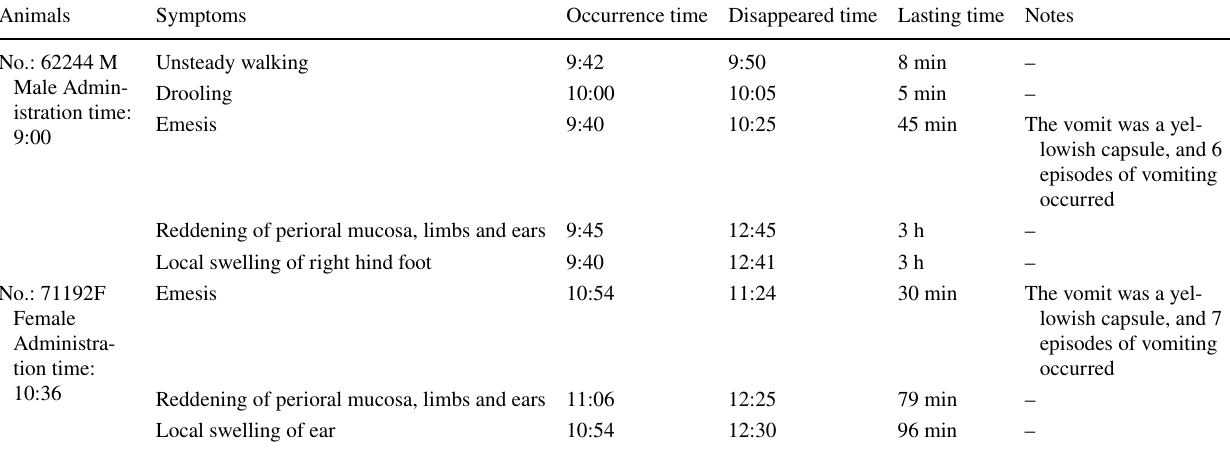
Table 1 Evaluation of acute toxicity of indole alkaloids derived from A. scholaris orally administered in beagle dogs